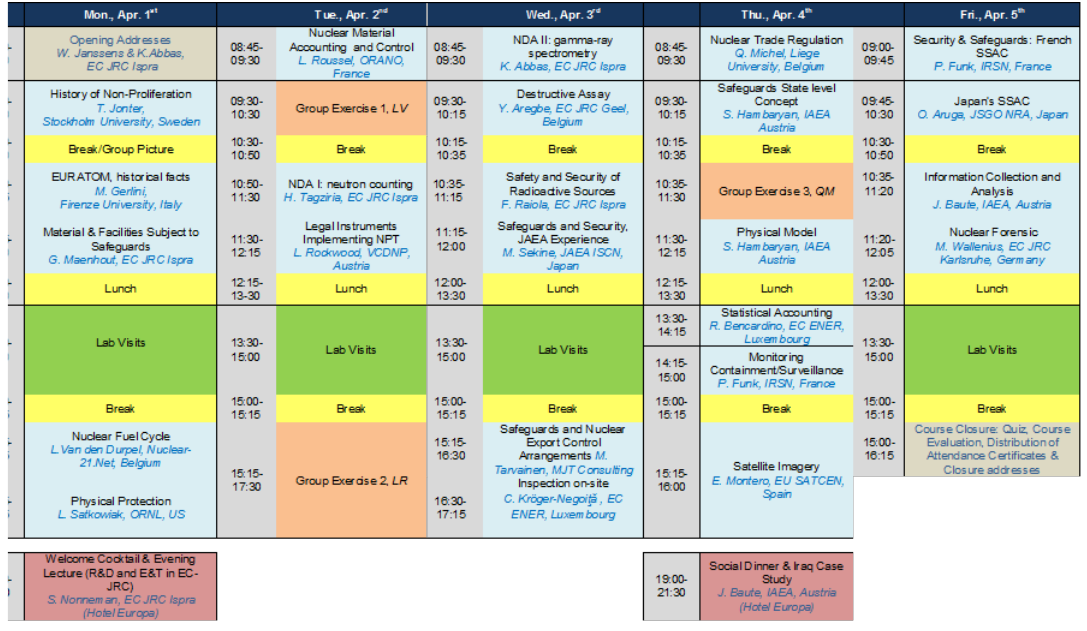
Figure 3: Typical ESARDA Course Schedule when implementing the course in